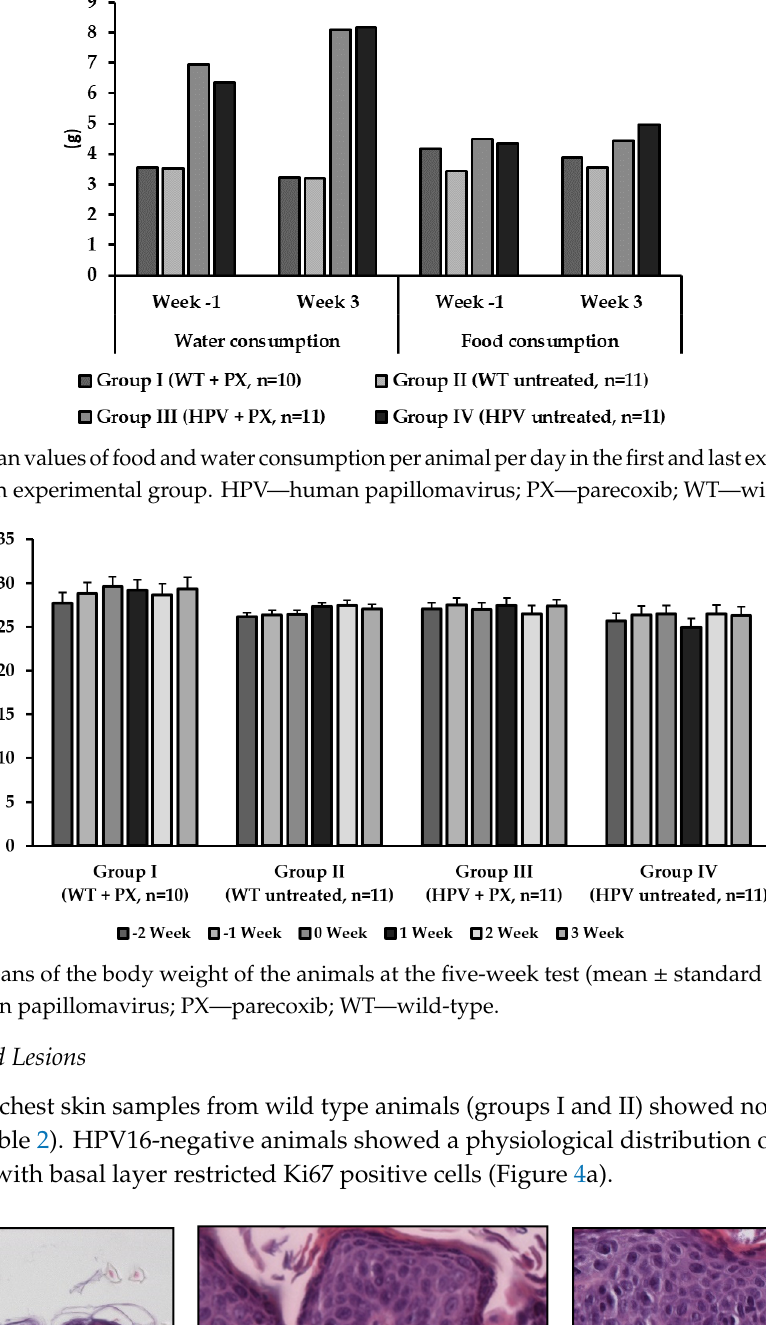
( b ) Figure 4. Immunohistochemistry for Ki67, in wild ‐ type ( a ) and HPV16 ‐ transgenic ( b ) mouse skin. In panel ( a ), Ki67 ‐ positive cells are restricted to the basal epidermal layer. In panel ( b ), Ki67 ‐ positive cells are scattered through all epidermal layers, reflecting HPV16 ‐ induced aberrant proliferation. 3,3’ ‐ diaminobenzidine (DAB)–Mayer ʹ s hematoxylin, 400×.